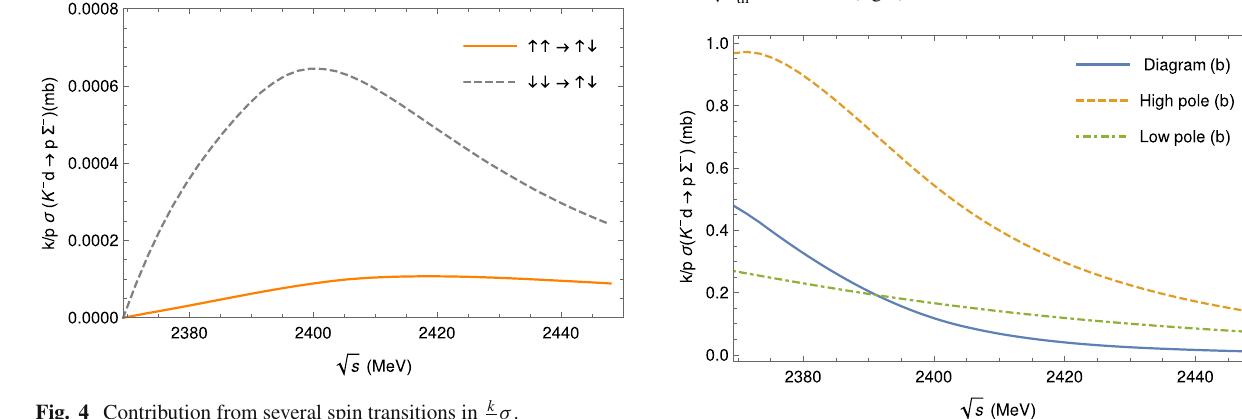
Fig. 4 Contribution from several spin transitions in k